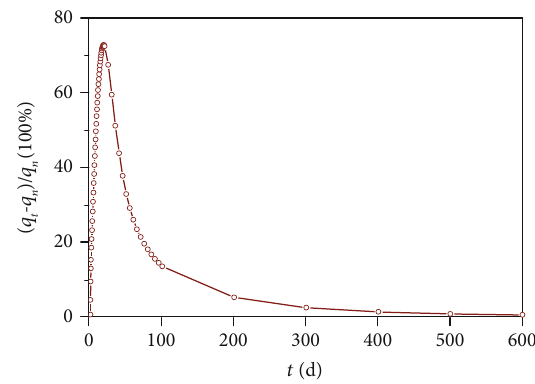
Figure 8: Increasing ratio of the fl ow rate with time for tree-like to lattice-like fractures q fractures q t